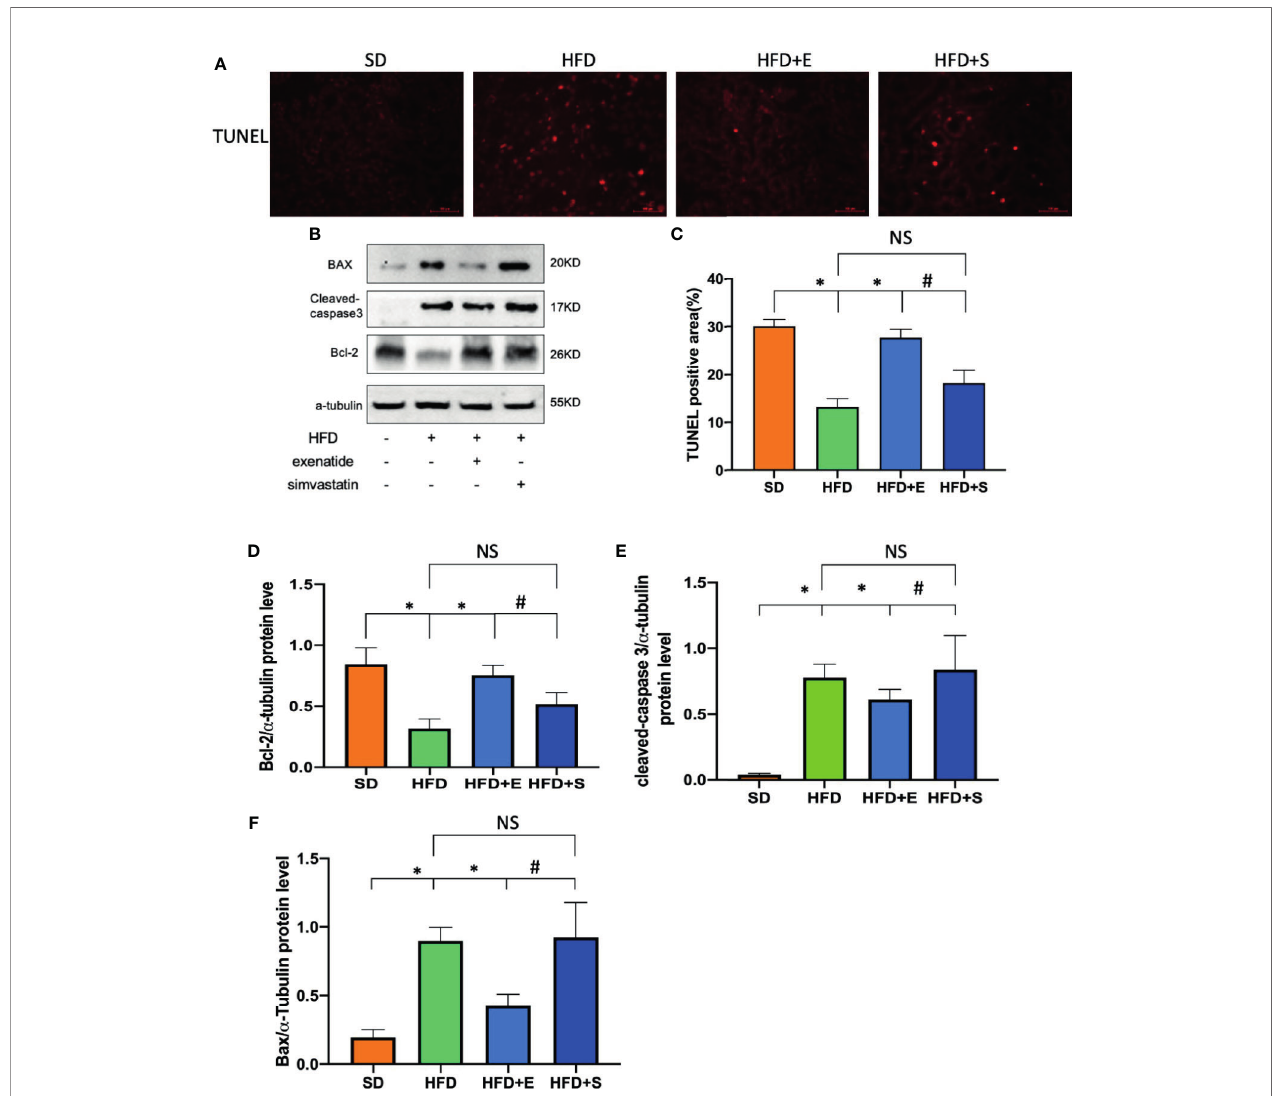
FIGURE 2 | Exenatide attenuated renal tubular apoptosis in HFD mice. (A) Kidney apoptosis was detected by TUNEL staining and fl uorescence microscopy (original image magni fi cation: ×200, bars=100 m m). (B) Western blots of cleaved caspase-3, BAX and Bcl-2 in renal lysates. (C) Quanti fi cation of TUNEL-positive cells in the kidney. (D – F) Relative protein expression of cleaved caspase-3, bax and Bcl-2. a -tubulin was used as a control for protein loading. Data are presented as the mean ± SD (n=3). *P < 0.01 versus HFD group. # p < 0.01 versus HFD+E group, NS no statistical difference between